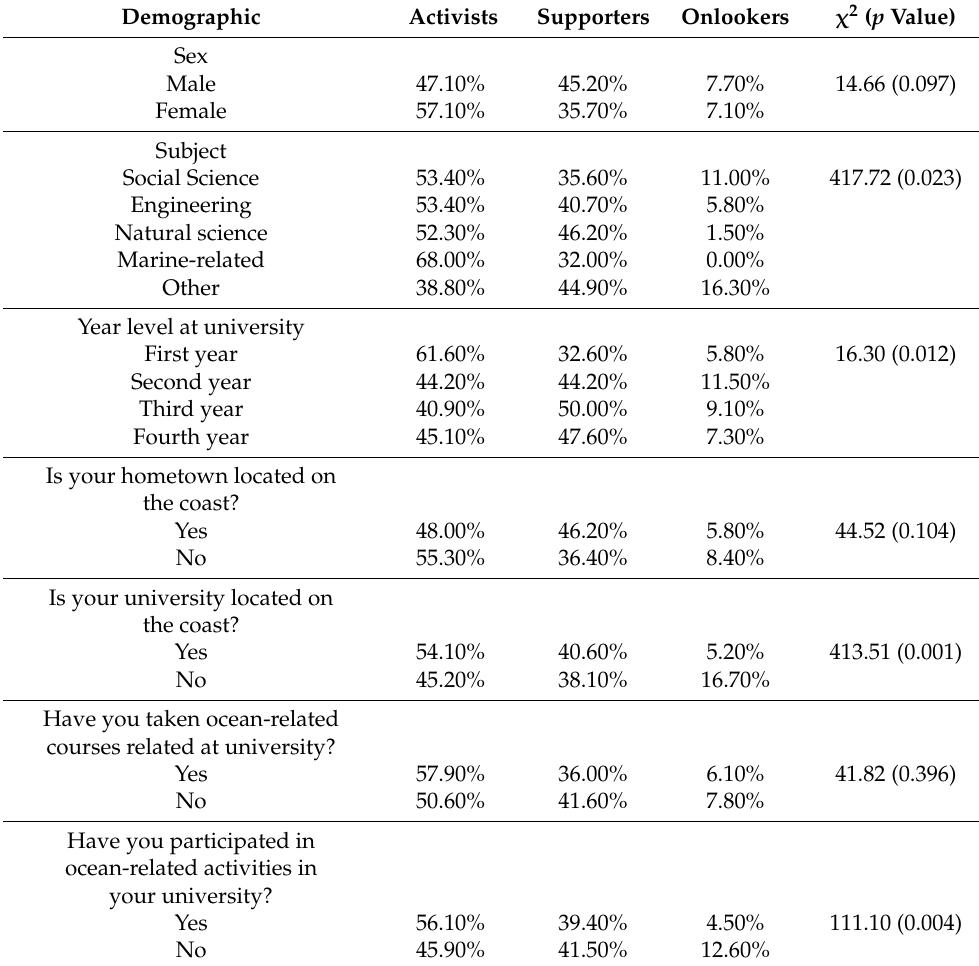
Table 6. Cluster profiles by demographic characteristics